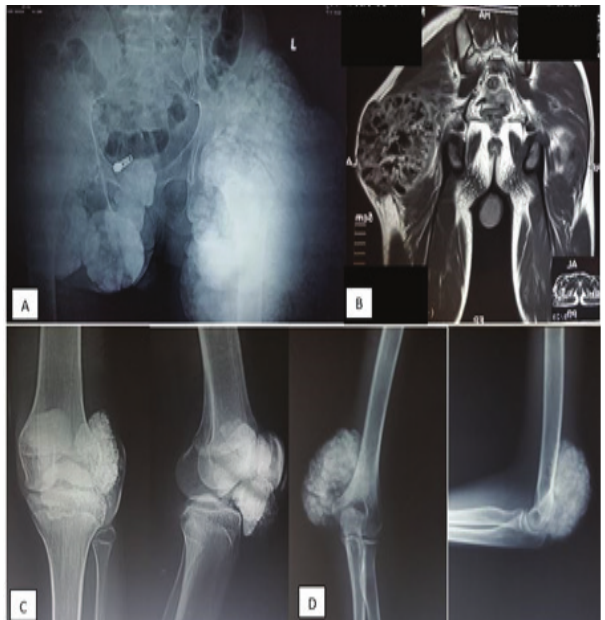
Figure-I: A) Radiographs of both hips at presentation showing huge calcific clouds around hip joints sparing the bone, B) Sagittal section MRI hip soft tissue relationship C & D) Radiographs of knee & elbow showing well-